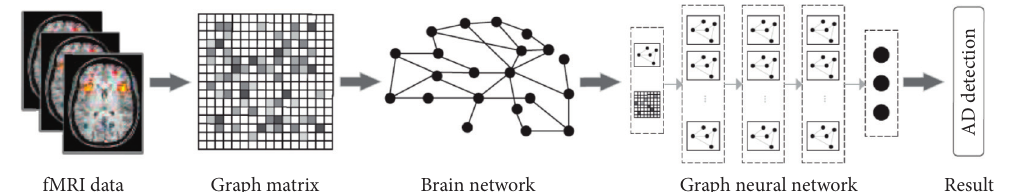
Figure 1: Graph learning for brain network classification for AD